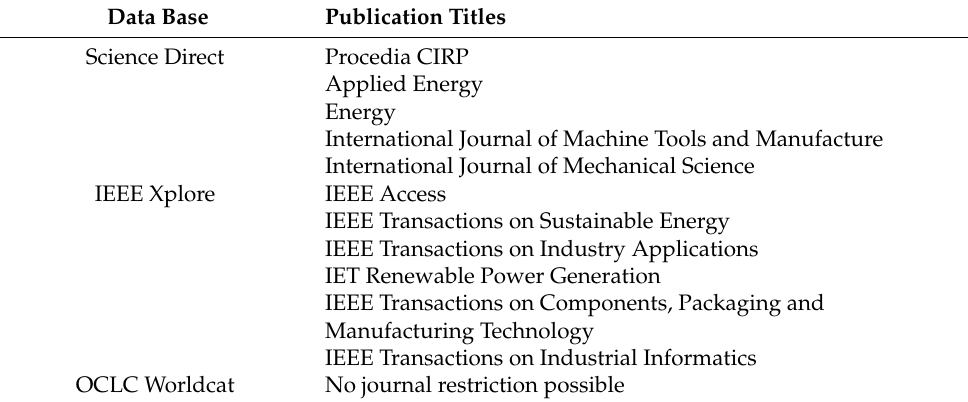
Figure 1. Methodology for systematic literature search. Table 1. Searched data bases with respective publication